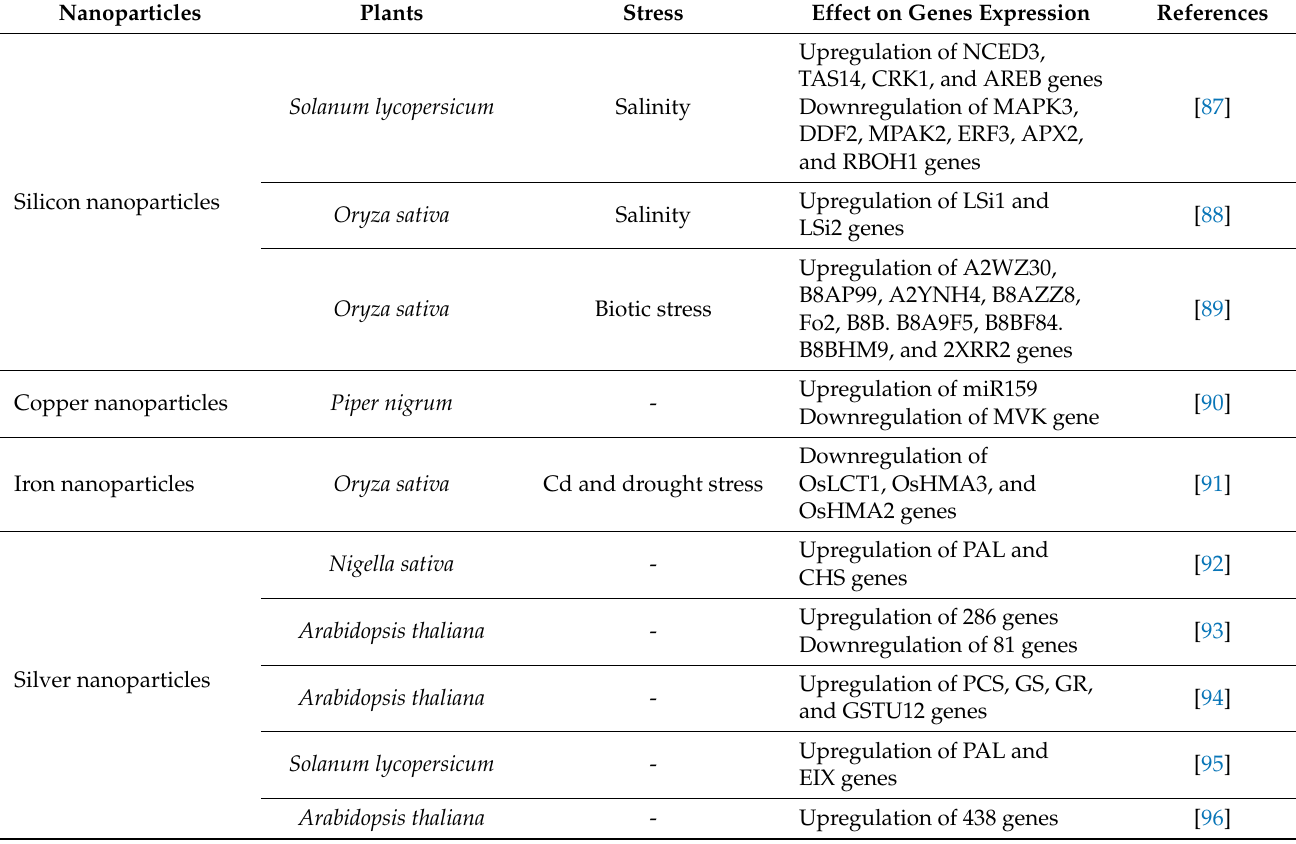
Table 1. Effect of nanoparticles on gene expression in